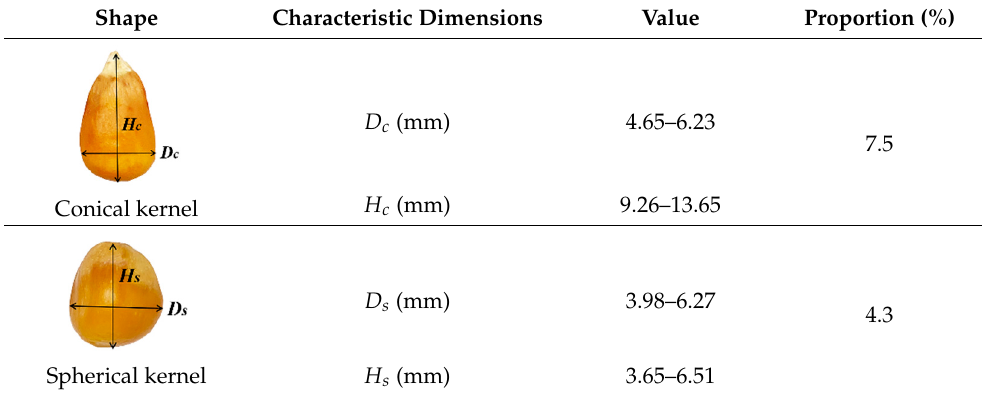
Table 4. Shapes and characteristic dimensions of corn kernels in three shapes.